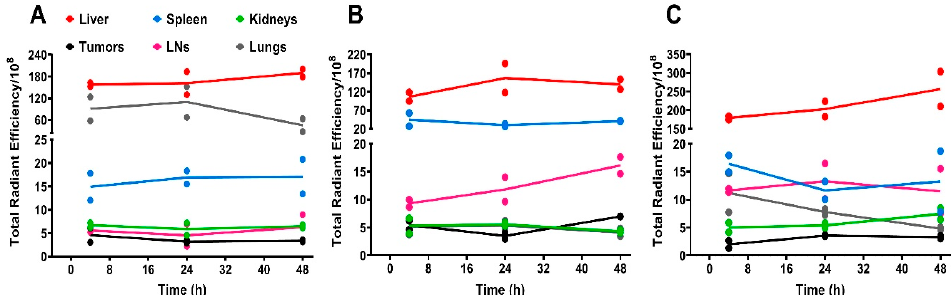
Figure 1. Biodistribution of PACA NPs containing the fluorescent dye NR668 in mice bearing MAS98.12 tumors. Organs were removed 24 h after i.v. injection. In vivo imaging system (IVIS) was used to image liver, spleen, kidneys, tumors, lymph nodes (LNs), lungs, heart, and brain. The color scale to the right indicates radiant efficiency. Control animals did not receive any treatment.